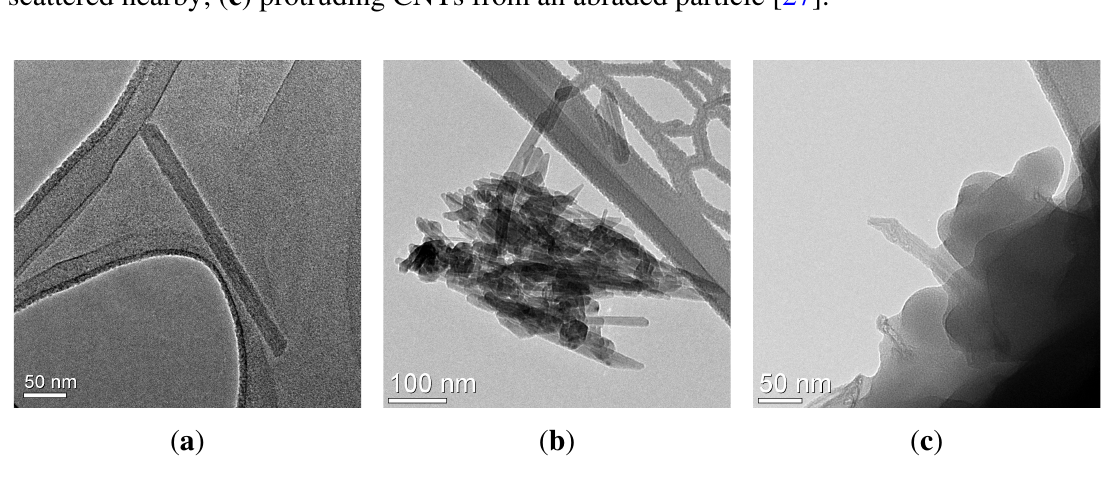
Figure 1. TEM images of abraded particles from an epoxy/CNT nanocomposite. ( a ) A free standing individual CNT; ( b ) an agglomerate of CNTs with a couple of individual CNTs scattered nearby; ( c ) protruding CNTs from an abraded particle